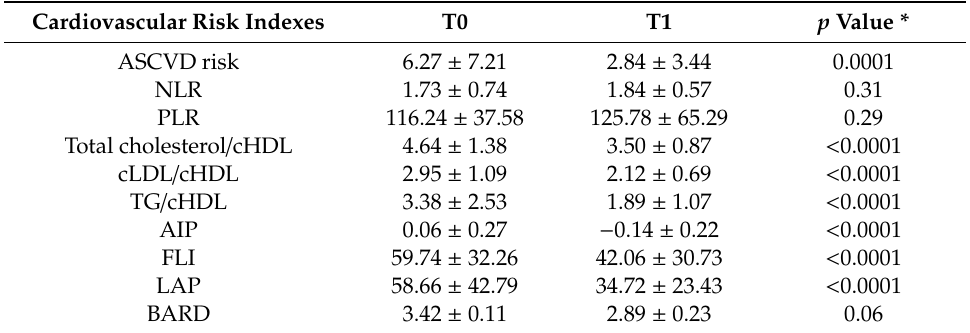
Table 2. Modification of risk markers after nutritional intervention and prescription of physical